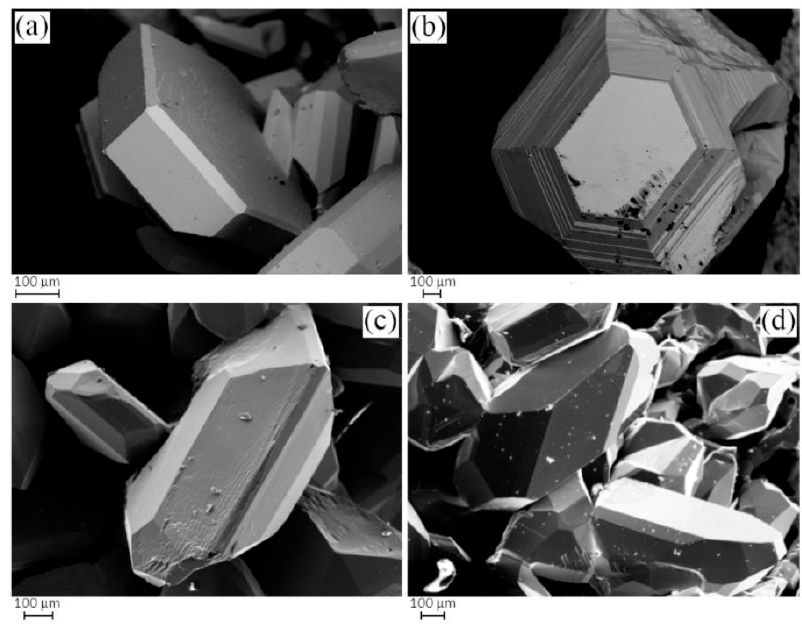
Figure 2. SEM microphotographs in Secondary Electron (SE) mode of selected samples; ( a , b ) show crystals grown after thermal treatment at 300 °C—20 days, while ( c , d ) show crystals grown after thermal treatment at 400 °C—14 days.